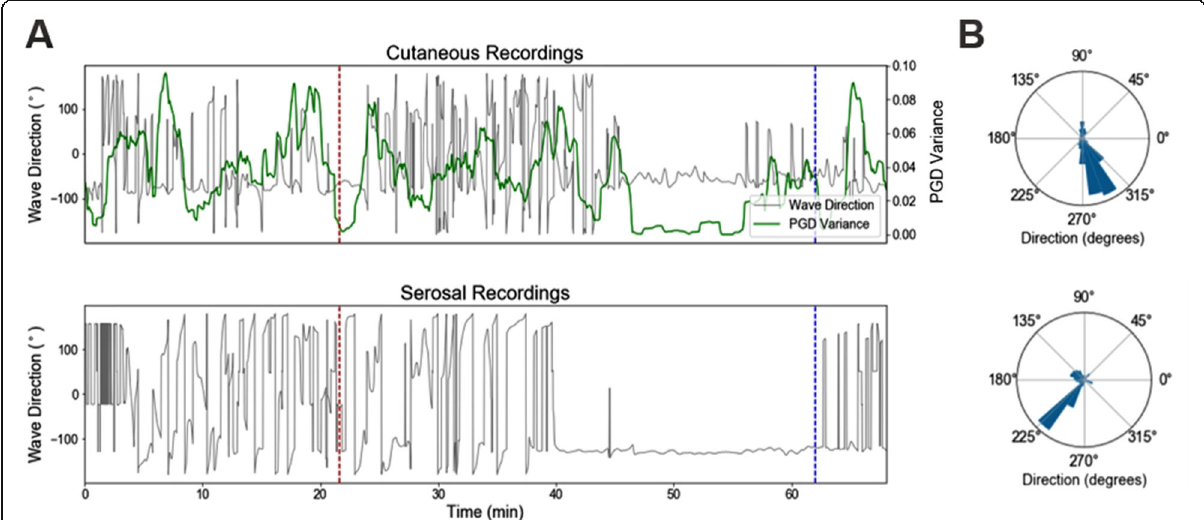
Fig. 5 Slow Wave Direction over Time. A Slow wave direction is plotted over time in the cutaneous and serosal electrodes. Red dotted vertical line represents the start of pacing and blue dotted vertical line represents the end of pacing. A buffer period of about 15 min is observed prior to the formation of a constant direction in the slow wave. This constant direction is observed to continue until termination of the stimulus. As expected, PGD variance was noted to decrease during this period. B Spatial histogram of the direction of the slow wave is plotted for PGD > 0.5, demonstrating the formation of this uniform